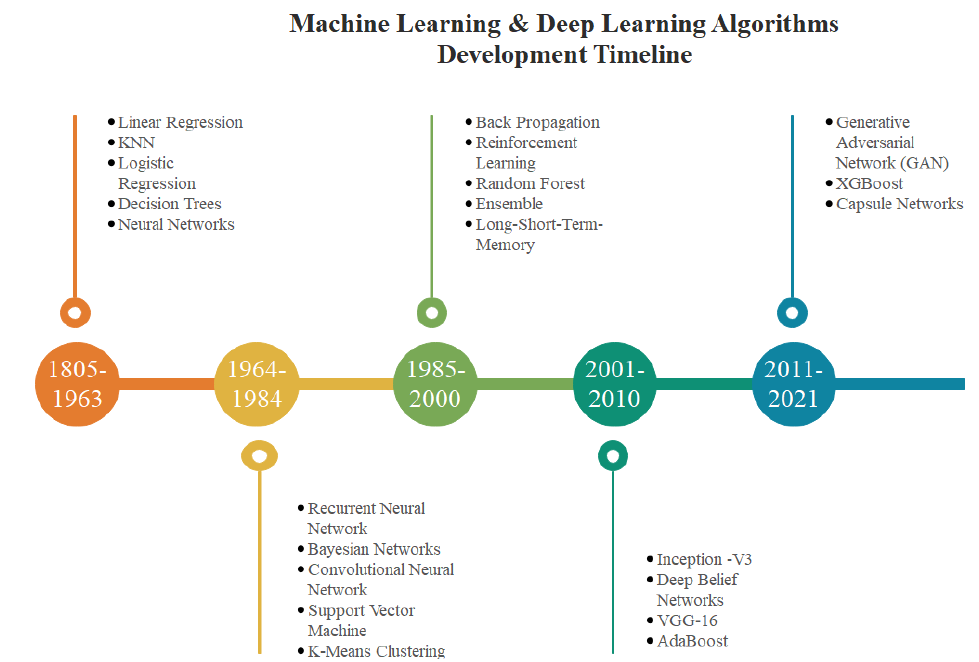
Figure 3. Illustration of machine learning and deep learning algorithms development